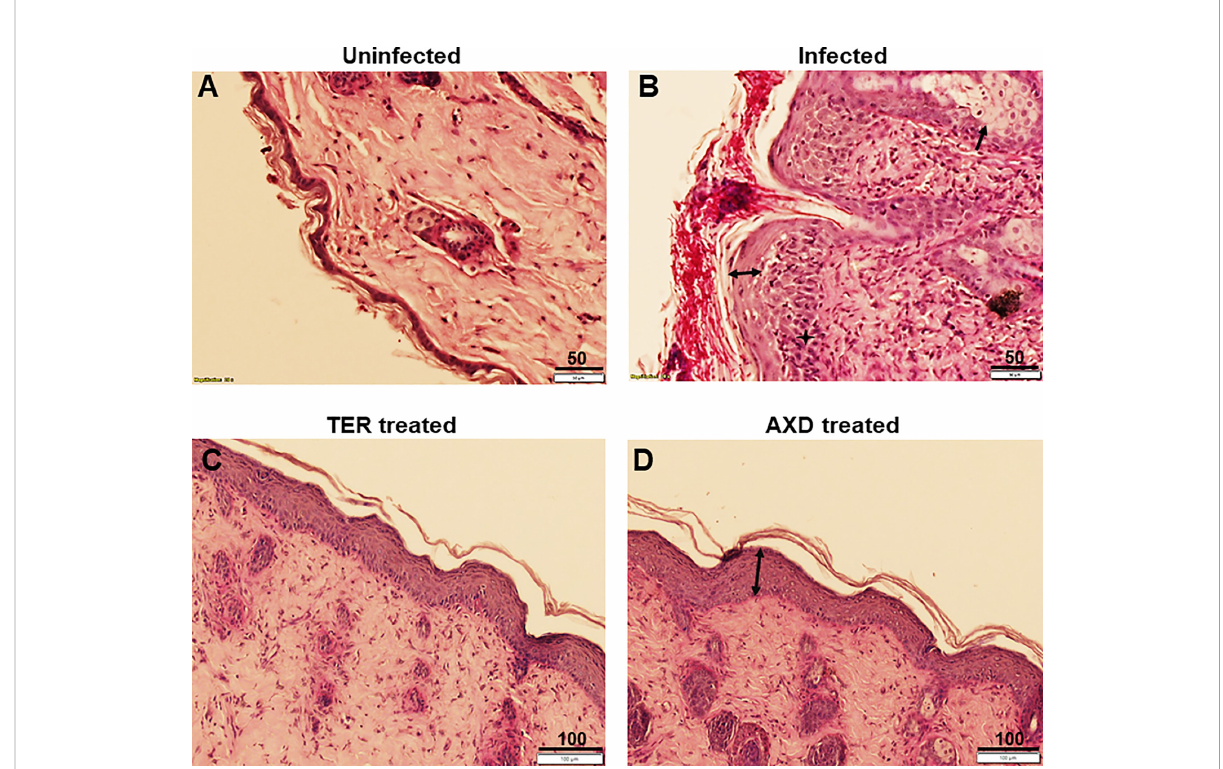
FIGURE 2 Histopathological analysis of skin: Skin biopsies obtained from uninfected, infected or drug treated mice skin were fi xed, sectioned and stained with H&E plus PAS stain. (A) shows structure of intact skin from uninfected control, (B) exhibits infection, and presence of extensive hyphae on the epidermal layer. Infection causes acanthosis (two headed arrow) and spongeosis (arrow), (C, D) show complete clearance of hyphae from the skin, and regeneration of the stratum corneum (although acanthosis is still observed). Scale bars as indicated in